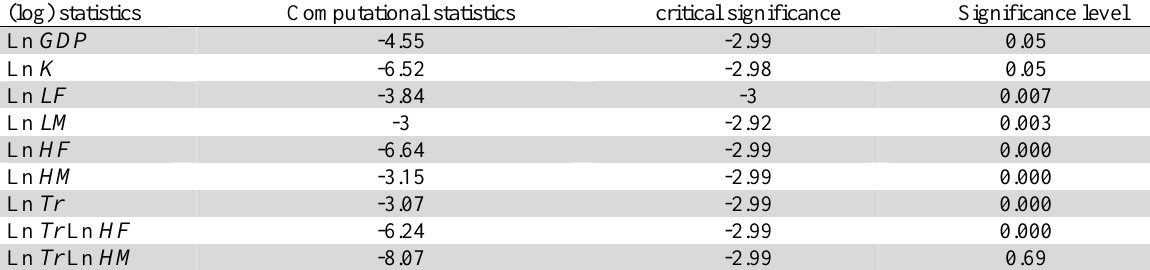
Unit root tests for the first difference of